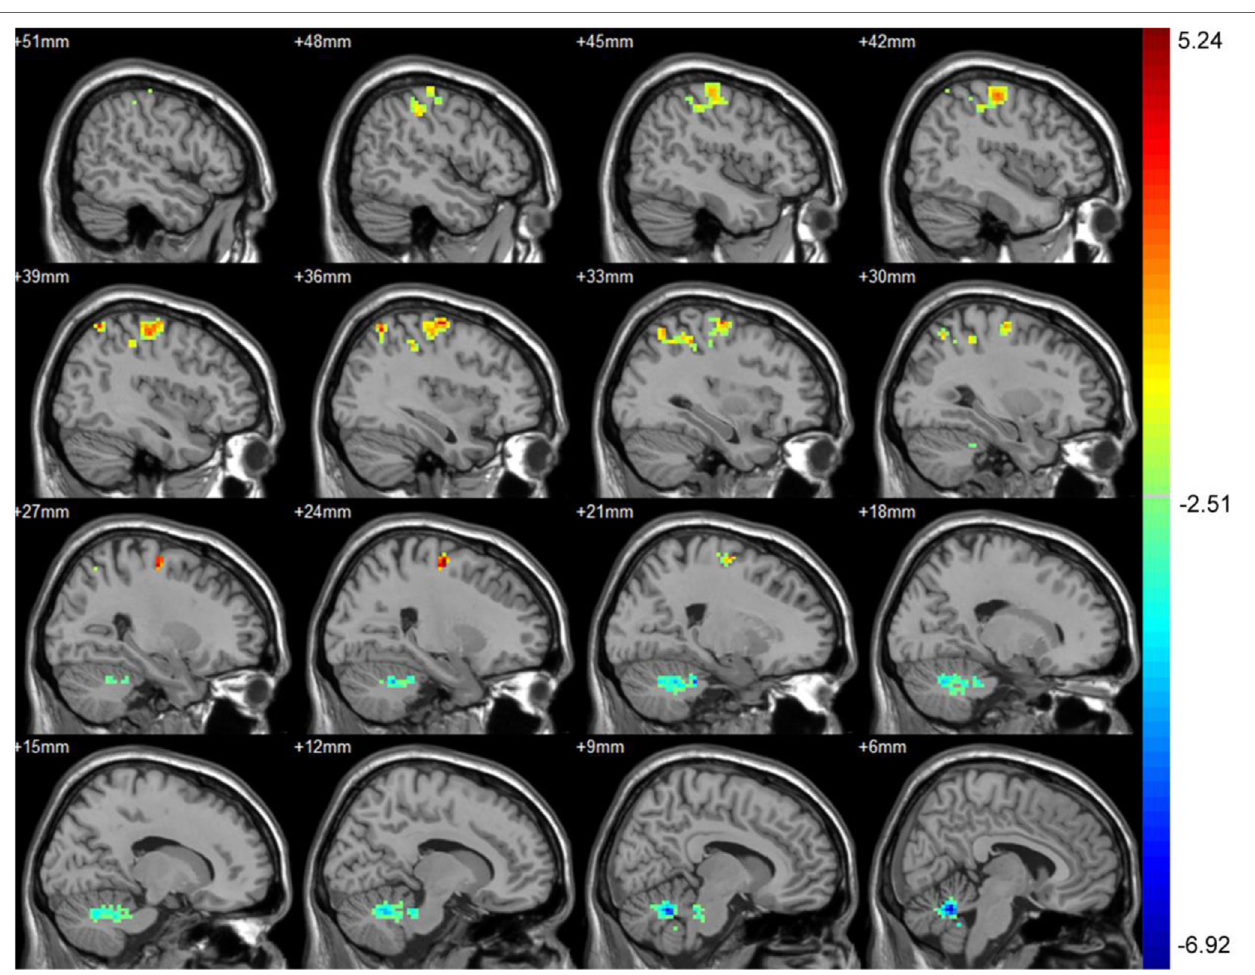
FigUre 2 | Significant difference in amplitude of low-frequency fluctuation (ALFF) between baseline and 3 months after treatment. After treatment, the asymptomatic carotid artery stenosis patients showed significantly increased ALFF predominantly in the right precentral gyrus. The asymptomatic carotid artery stenosis patients also showed decreased ALFF mainly in the left and right cerebellum anterior lobe. Red indicates 3 months after treatment > baseline and blue indicates 3 months after treatment < baseline. The result was corrected using the AlphaSim program, which was set at P < 0.01 and number of voxels > 175, which was corresponded to a corrected P < 0.025. TaBle 4 | Significant connectivity difference to the posterior cingulate cortex between baseline and 3 months after intervention with their location. number of